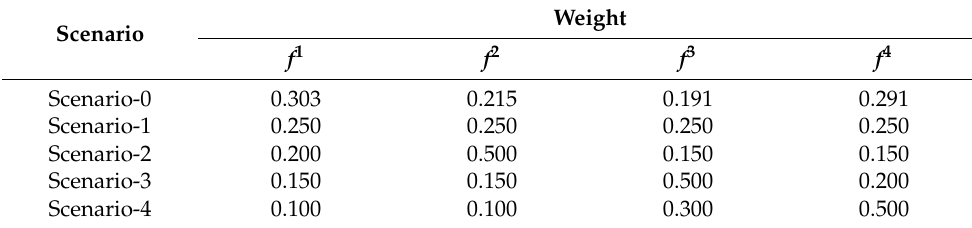
Table 11. Scenarios description.